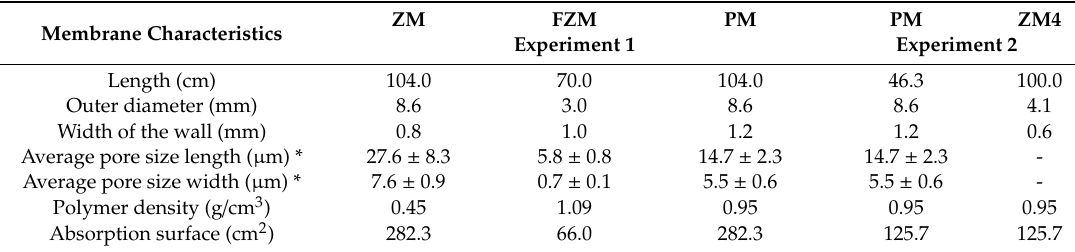
Figure 1. Diagram of the process of ammonia uptake by the gas-permeable membrane in a closed loop. The membranes were made of expanded polytetrafluoroethylene (ePTFE), but with di ff erent characteristics: ZM, ZM4, FZM (ZEUS Industrial Products Inc., Orangeburg, SC, USA), and PM (PRODYSOL Company) (Table 1). Table 1. Characteristics of the